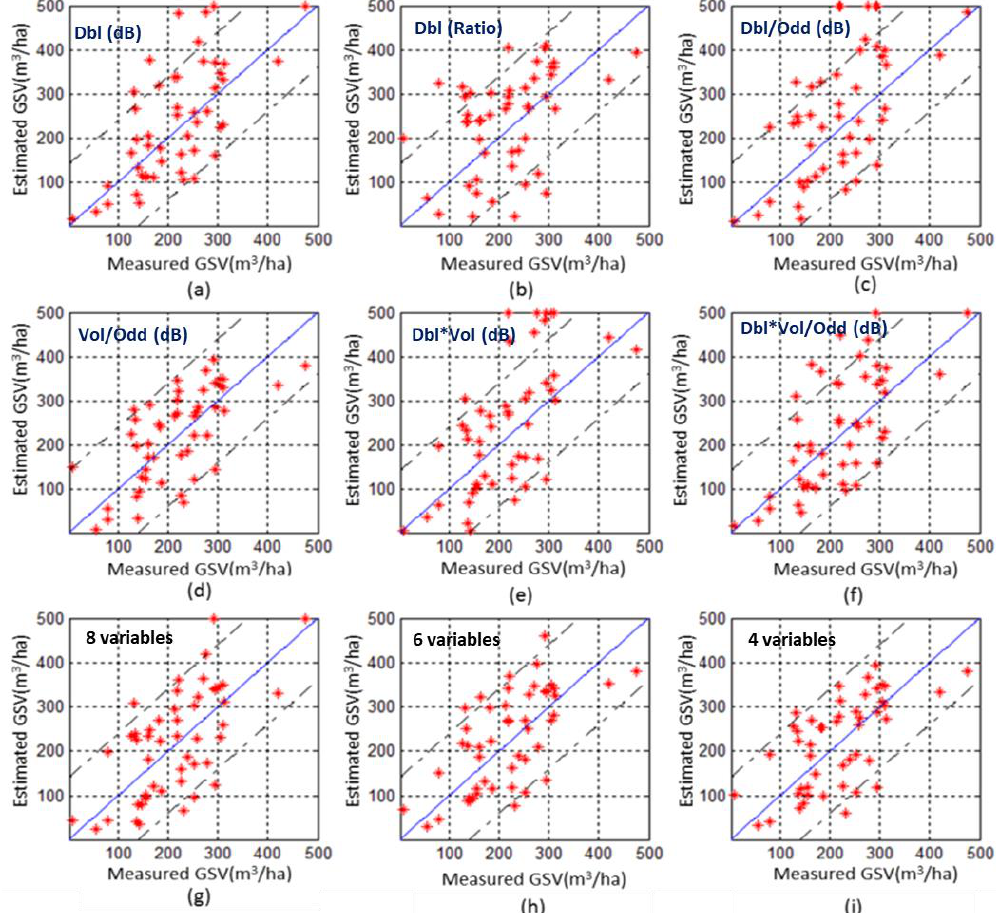
Figure 6. The scatter graphs between the observed and estimated GSV values of the plots using the image dated on 30 June 2016: ( a , b ) are the GSV estimated by the powers of Dbl after logarithm and ratio transformation, respectively; ( c – g ) are the GSV estimated by the fused variables; ( g – i ) are the GSV estimated from the saturation-based multivariate approach with eight variables, six variables and four variables,